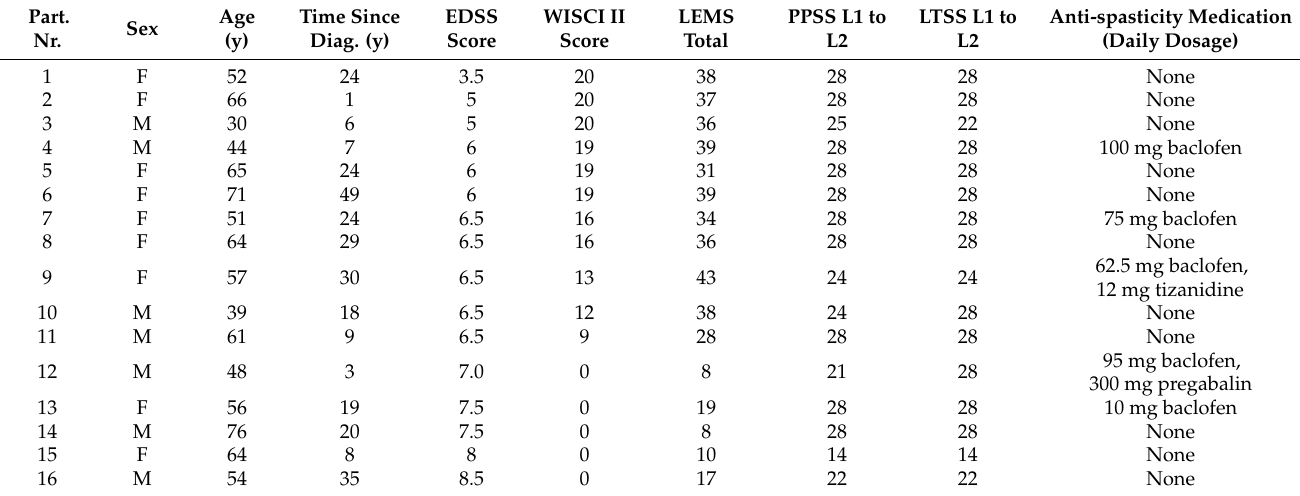
Table 1. Clinical characteristics of study